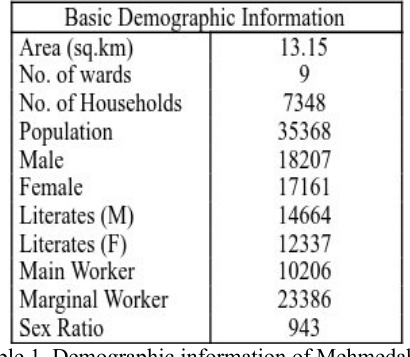
Table 1. Demographic information of Mehmedabad